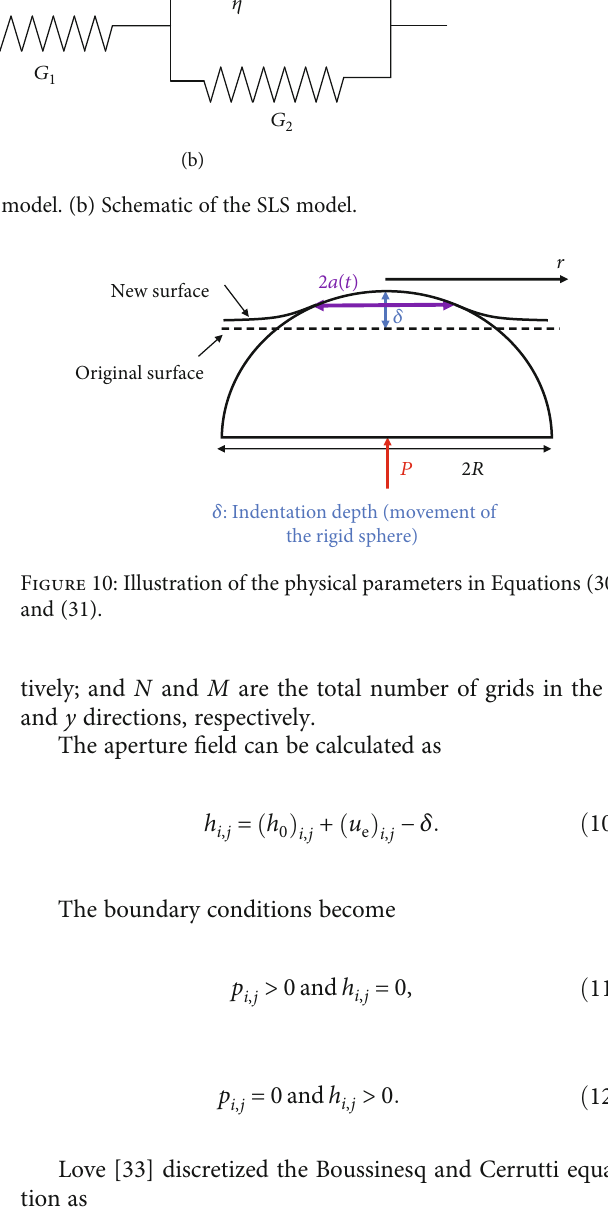
Figure 9: (a) Schematic of the Maxwell model. (b) Schematic of the SLS model.